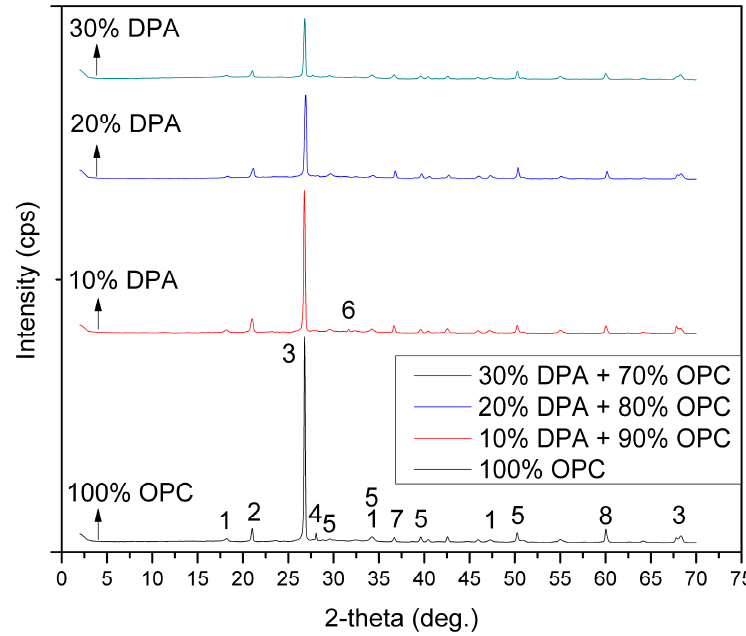
Figure 9. Surface area distribution in all mixtures.